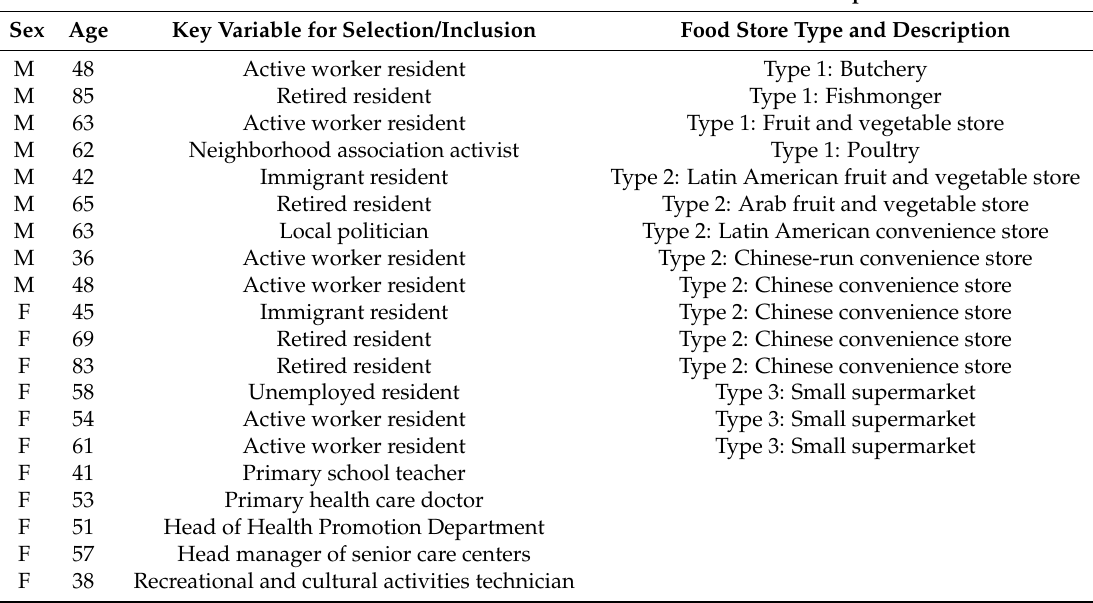
Table 1. Profile of neighborhood residents ( N = 20) and food traders ( N = 15) interviewed. Food Traders ( N = 15). 1 = Small Neighborhood Residents ( N = 20). M = Male; F = Female